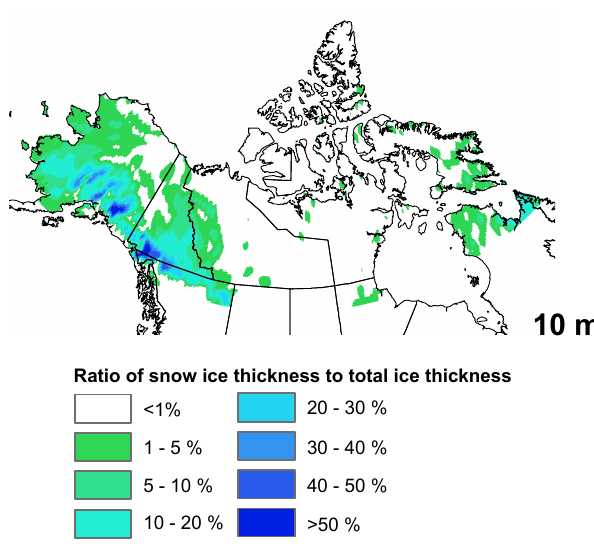
Fig. 8. Ratio of mean snow ice thickness to mean maximum ice thickness for